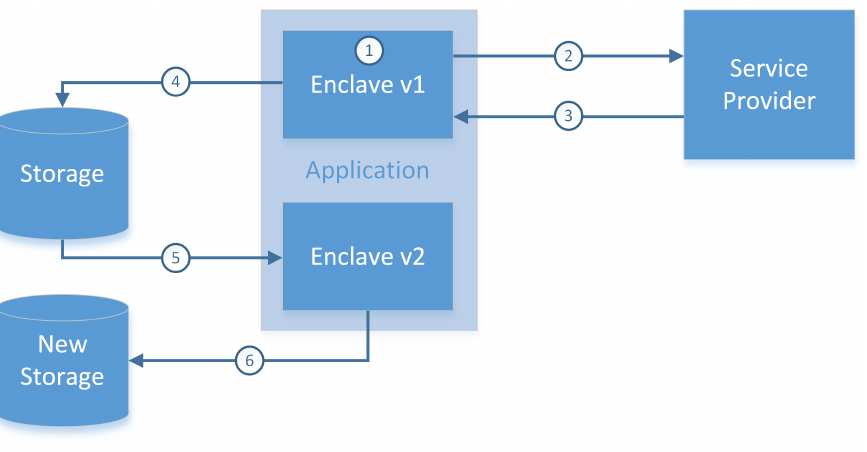
Figure 2. Intel SGX Software Lifecycle; steps are executed in the numerical order, sensitive data are remotely provisioned (3) into the enclave after mutual attestation (2) of the off-platform provider and created enclave (1), after the enclave is destroyed data are sealed in memory (4) in such a way that only an identical enclave can access them again. Software updates (5) are also possible via this scheme and a new seal is created (6) so that an old version of software cannot overwrite the new version. Based on